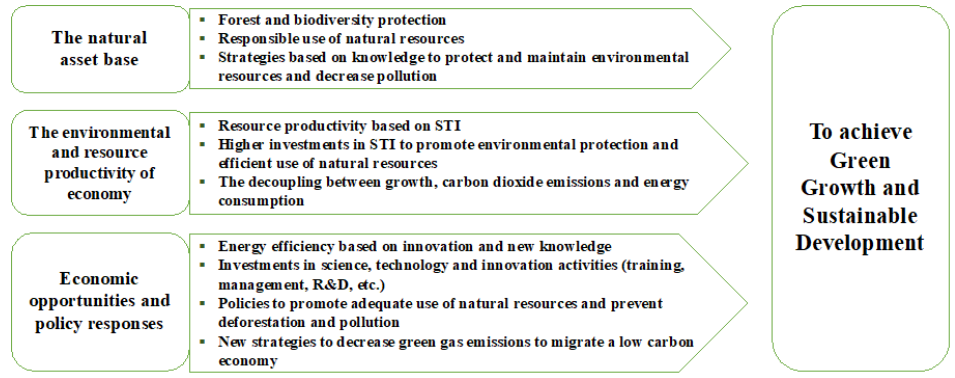
Fig. 3. Results and relationship with green growth and sustainable